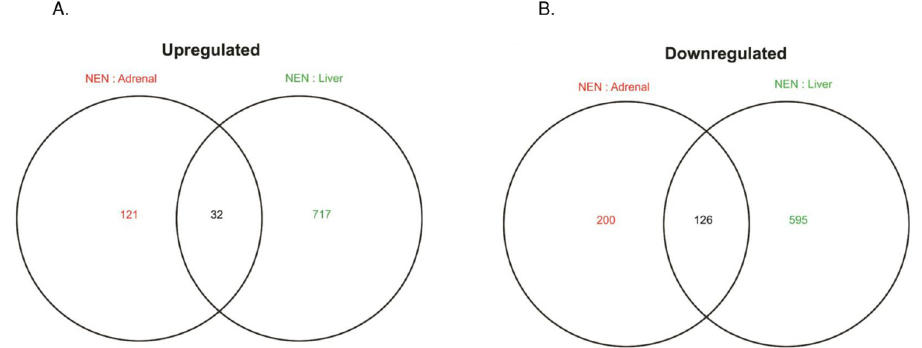
normal adrenal (red text) and liver tissue (green text). Up/downregulated proteins were statistically significant if fold change > 2, p-value < 0.05.